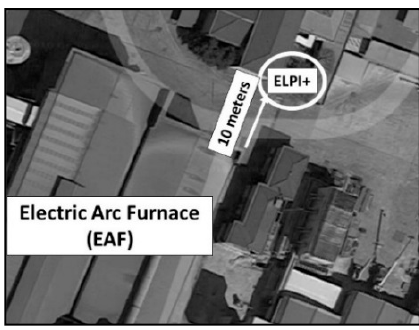
Figure 2. Outdoor sampling site: Sampling site outside of the plant near the electric arc furnace.